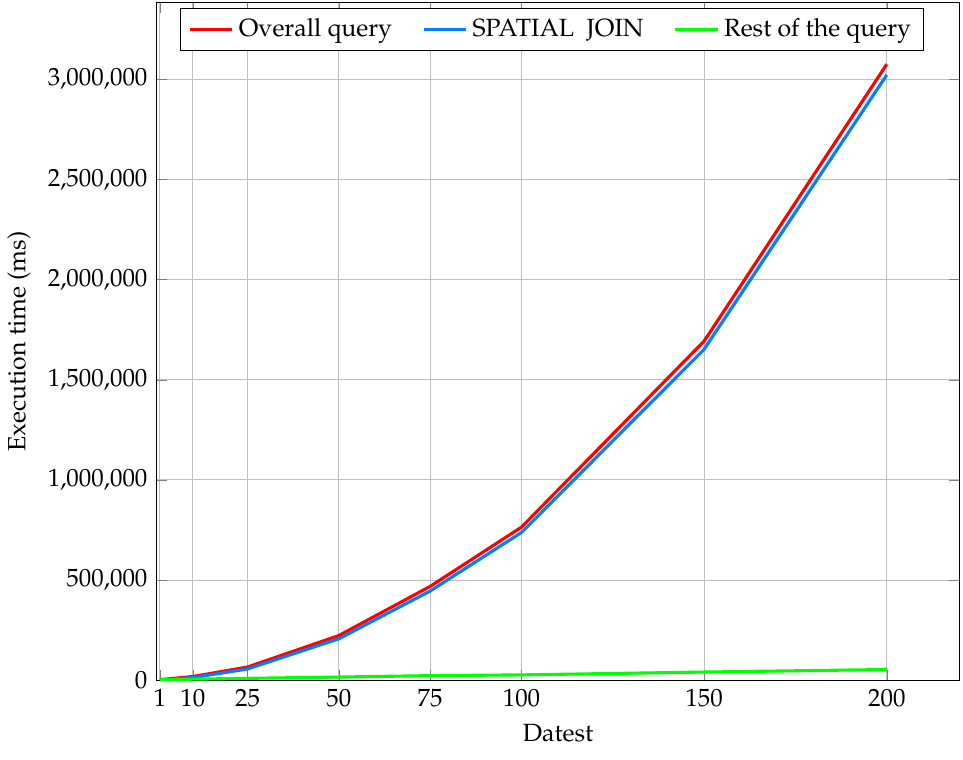
Figure 7. Overall query vs. SPATIAL JOIN vs. Rest of the query (execution times). This behavior is further highlighted by Figure 8, which plots two curves: the blue line shows the percentage of execution time taken by the SPATIAL JOIN instruction;